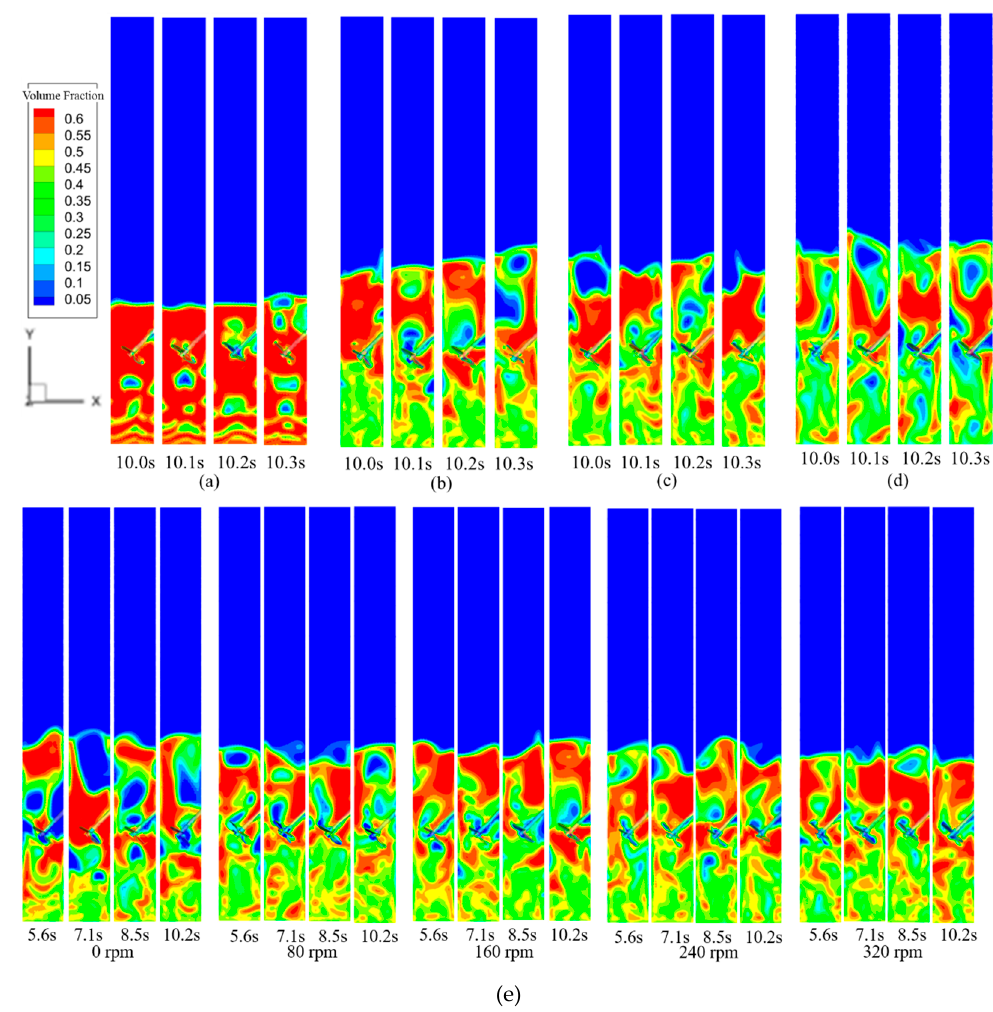
Figure 4. Cloud chart of volume fraction distribution of iron ore powder. ( a ) Pure H 2 . ( b ) The volume ratio of H 2 to CO is 1:1; ( c ) the volume ratio of H 2 to N 2 is 1:1. ( d ) Pure CO. ( e ) Different agitation speeds when the volume ratio of H 2 to CO is 1:1.